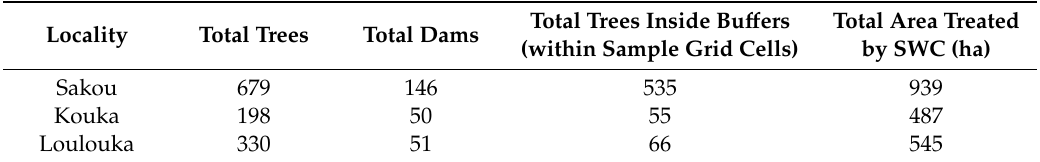
Table 2. Summary of dams, trees, and SWC by village.